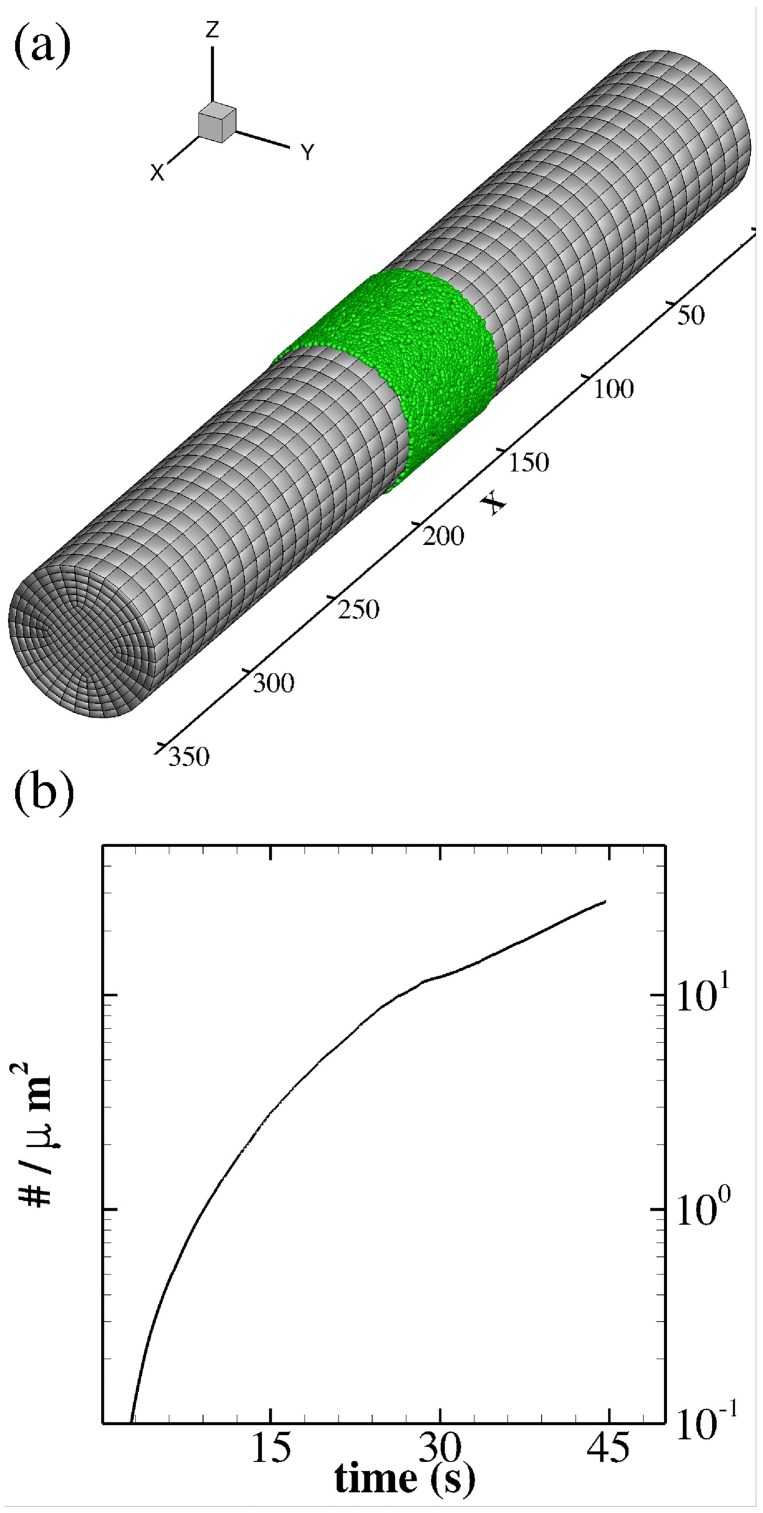
Blood coagulation and thrombus formation in a venous flow.(a) Schematic of the simulation setup with the seeded particles (green) placed circumferentially to represent the subendothelial matrix (150 − 200 μm). The hexahedral elements show the structured grid used to solve the N-S and ADR equations. (b) Time course of platelet aggregation density on the injured area at 64 s−1 shear rate.